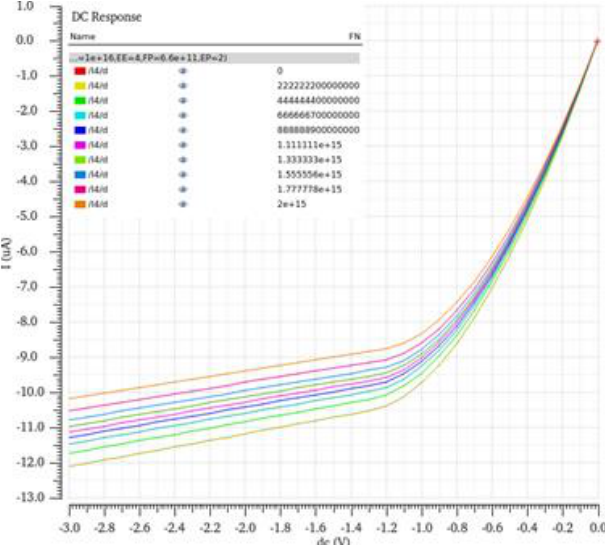
Fig. 3. Dependence I D (V D ) with neutron fluence variation with E N = 1,5 MeV.